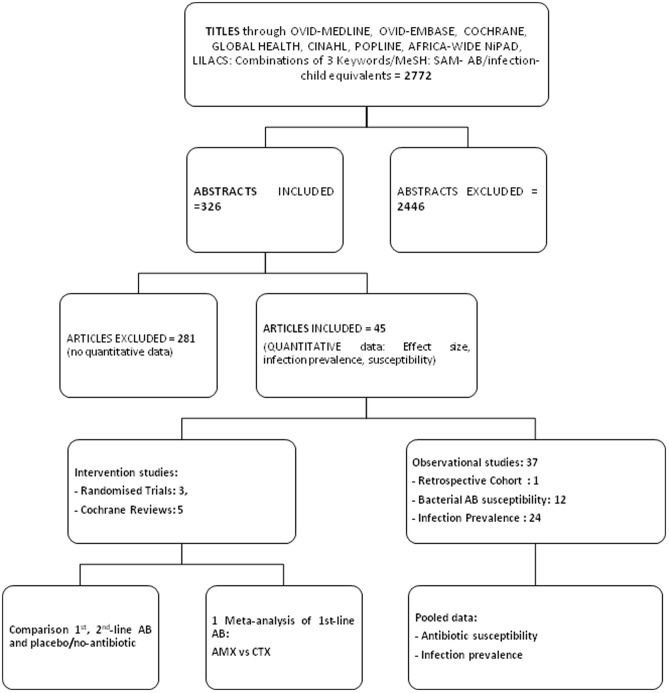
Search results on PRISMA Flowchart (Preferred Reporting Items for Systematic Reviews and Meta-Analyses).